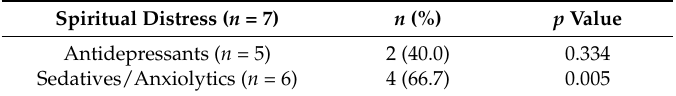
Table 4. Psychotropic medication use related to spiritual distress diagnosis.